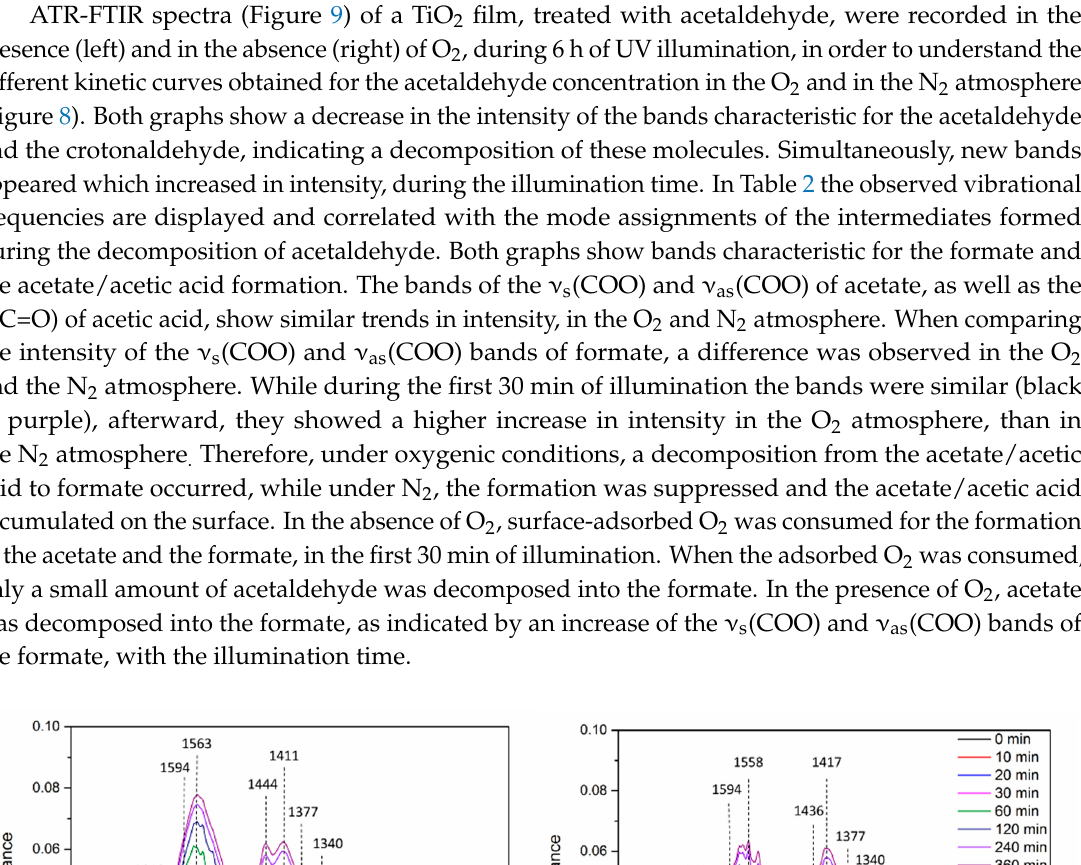
Figure 8. Acetaldehyde concentration as a function of time upon UV illumination in O 2 ( left ) and N 2 ( right ) atmosphere.